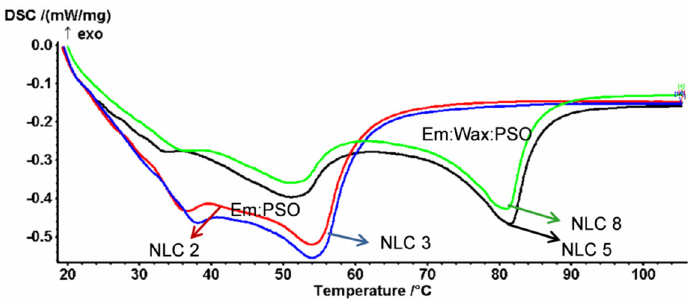
Figure 6. DSC curves of the NLCs loaded with AVO and OCT (NLC 2 and 5) in comparison to BEMT – NLCs (NLC 3 and 68.0DSC parameters, enthalpy ( Δ H, J g -1 ) and melting peak (Mp, °C) of free and loaded – NLCs, and of their corresponding physical mixtures (PM).